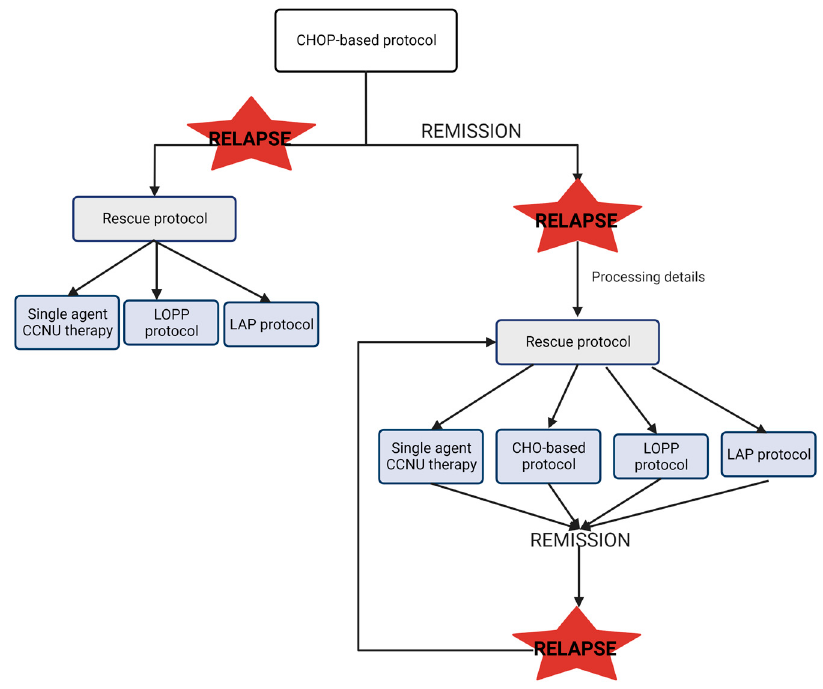
Figure 2. Scheme of common treatment protocol in CML. CHOP: Wisconsin–Madison protocol; CCNU: lomustine; LOPP: vincristine procarbazine and prednisolone protocol. LAP: lomustine, L-asparaginase and prednisone protocol [35,36].